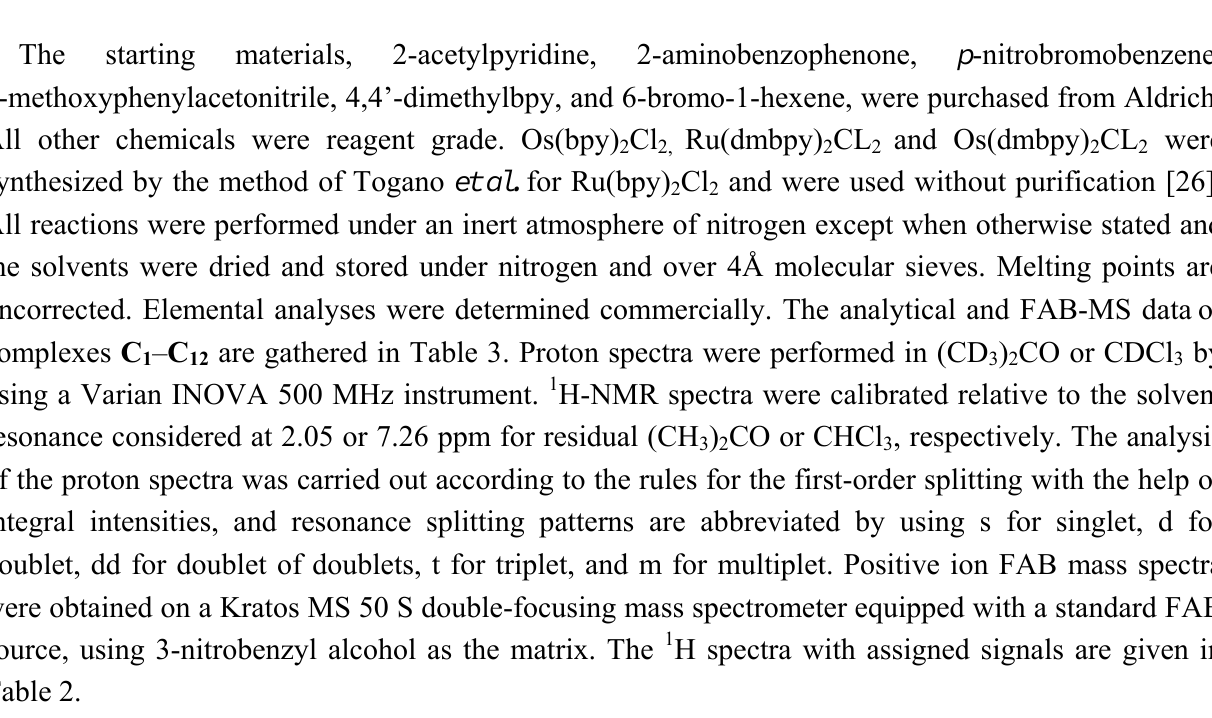
Table 3. Analytical and Positive ion FAB-MS Spectral Data for the Complexes C